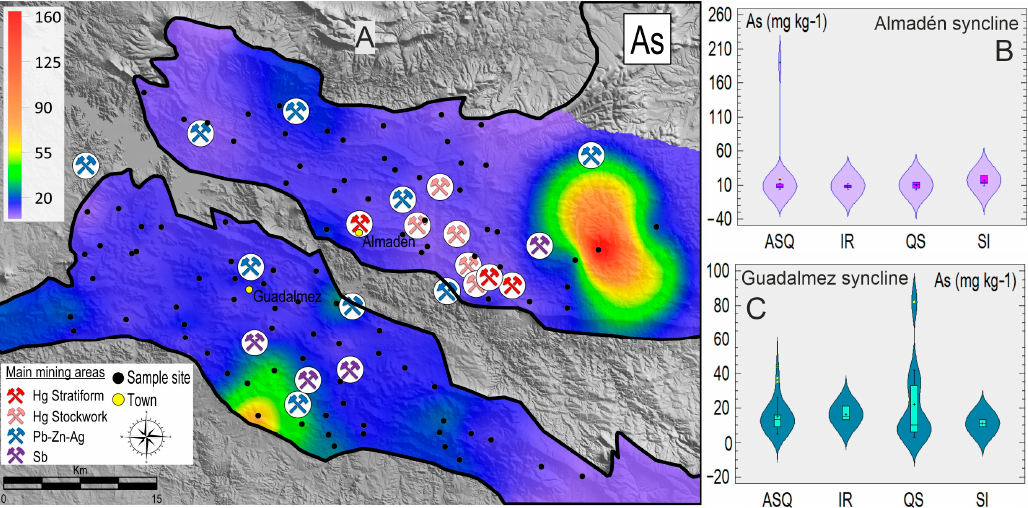
Figure 5. Spatial distribution maps ( A ) and violin plots ( B , C ) of trace elements (all data are expressed as mg kg − 1 ). ASQ: alternations of shales and quartzites, IR: igneous rocks, QS: quartzites and sandstones, Sl: slates.